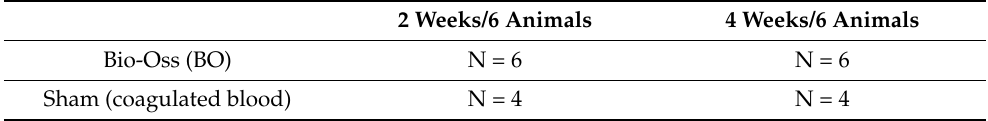
Table 1. Table 1. Samples.